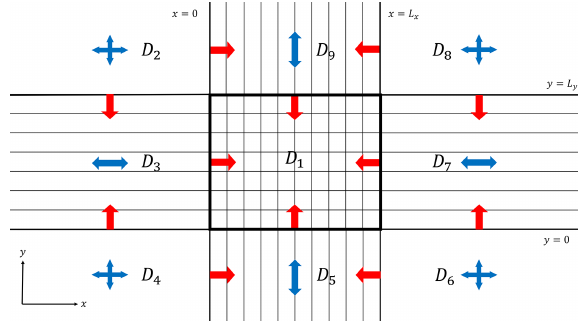
Figure 2. Top-down view of the geometry of the system of RT prob- lems. D 1 denotes the domain of 3D RT. The blue arrows denote the directions in each domain for which there are periodic horizontal BCs. The red arrows denote which domains supply incoming radi- ances at each boundary. For example, the RTE problem solved on D 3 supplies the horizontal radiance BCs to the 3D RTE problem solved on D 1 at the common plane shared between them.